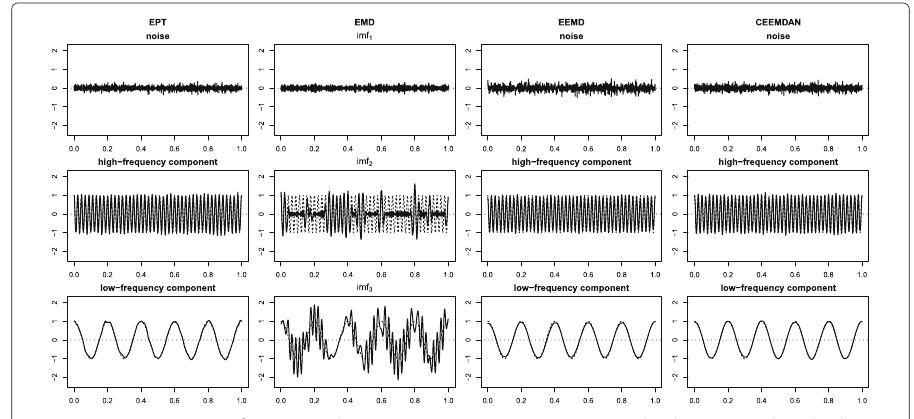
Fig. 15 Decompositions of noisy signal X t + (cid:6) t , X t = cos ( 90 π t ) + cos ( 10 π t ) by the proposed method, EMD, EEMD, and